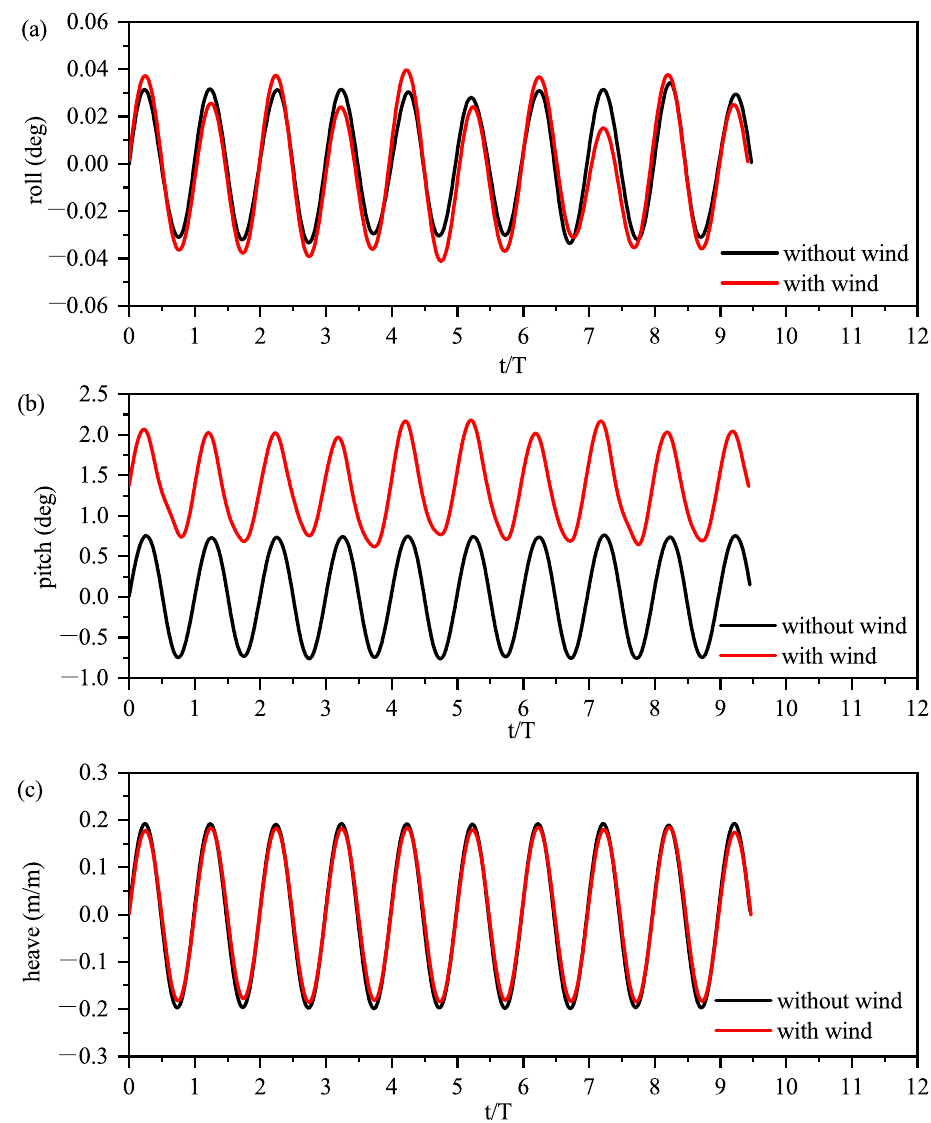
Figure 15. Motion response of the HFS in the roll, pitch, and heave directions with and without winds ( H = 1 m, T = 4.213 s): ( a ) surge motion; ( b ) pitch motion; ( c ) heave